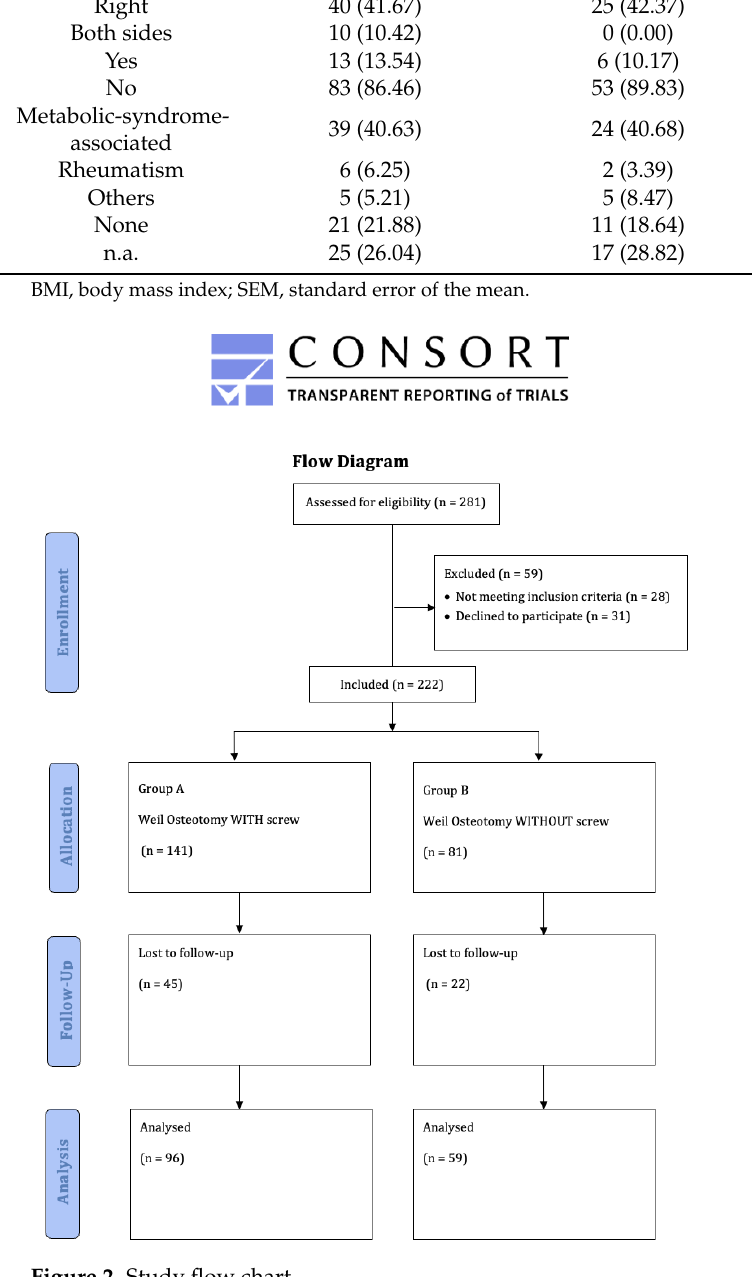
Figure 2. Study flow chart. Table 1. Patient characteristics.